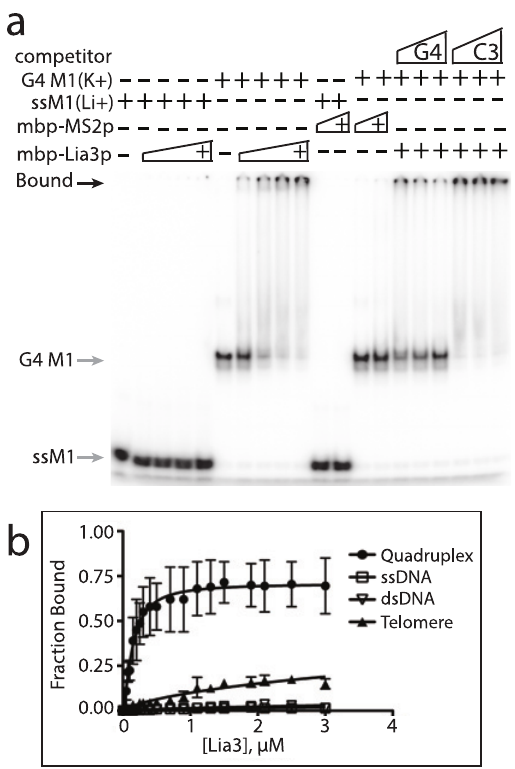
Fig 6. Lia3 binds a parallel G-quadruplex forming oligonucleotide in vitro . (a) 50 – 400 nM MBP-Lia3 was incubated with ssM1 (LiCl) or G4 M1 (KCl) probes and binding was analyzed on 5% polyacrylamide gels. Increasing amounts of either wt M1 or C3G2 mutant M1 oligonucleotide was added to assess competition in the presence of 400 nM MBP-Lia3. (b) Binding curves as determined by EMSA for His-Lia3 binding to ssM1, dsM1, G4-M1, and G4- Tetrahymena